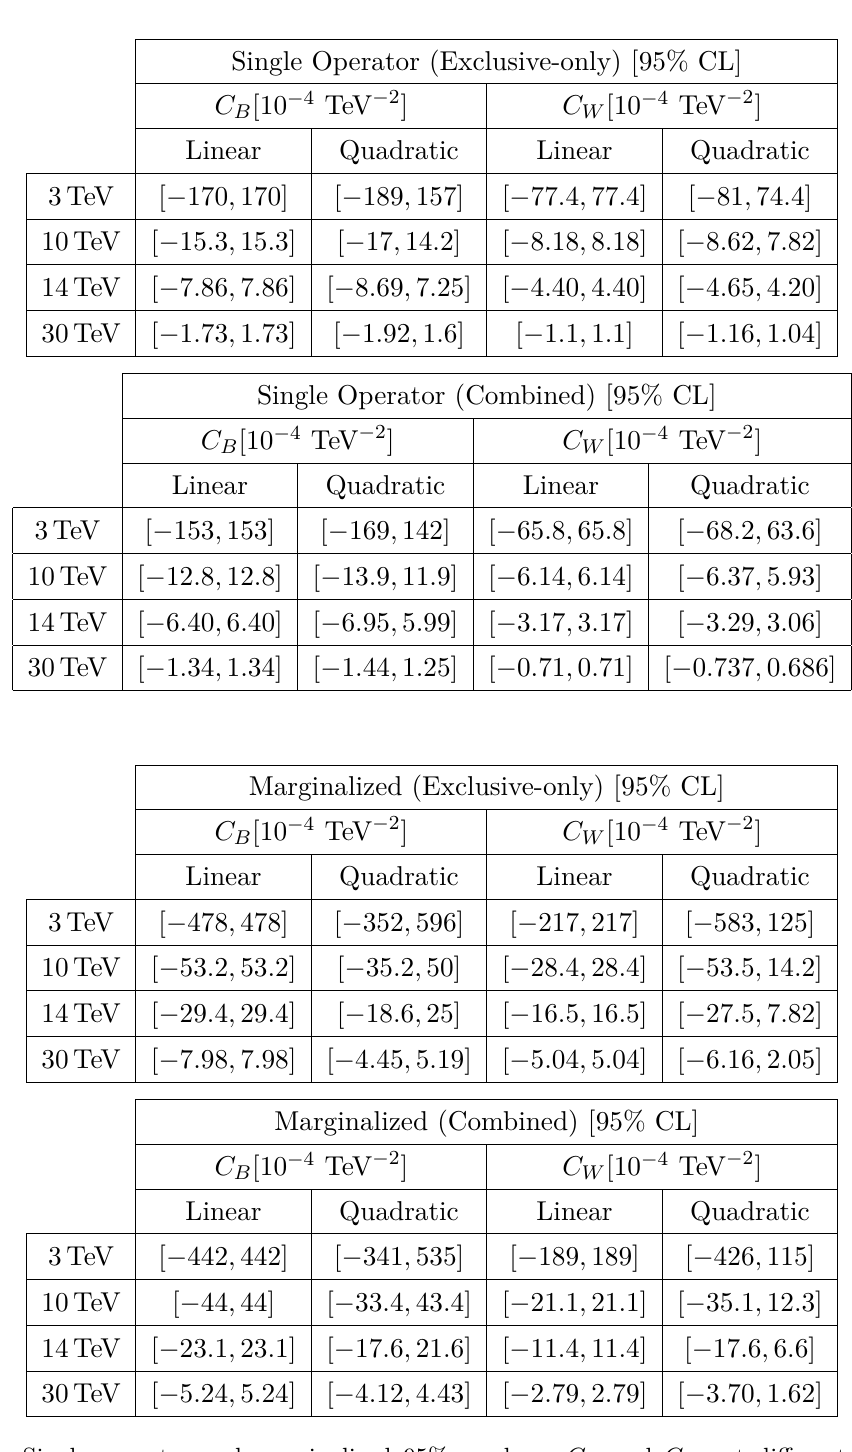
Table 5. Single operator and marginalized 95% reach on C B and C W , at different muon col- lider energies. The sensitivity of exclusive cross-section measurements alone is shown separately from the combination of all the measurements. The significant degradation of the marginalized bounds relative to the single-operators ones, and the strong sensitivity to the quadratic terms at the marginalized level, is due to the approximately flat direction displayed in figure